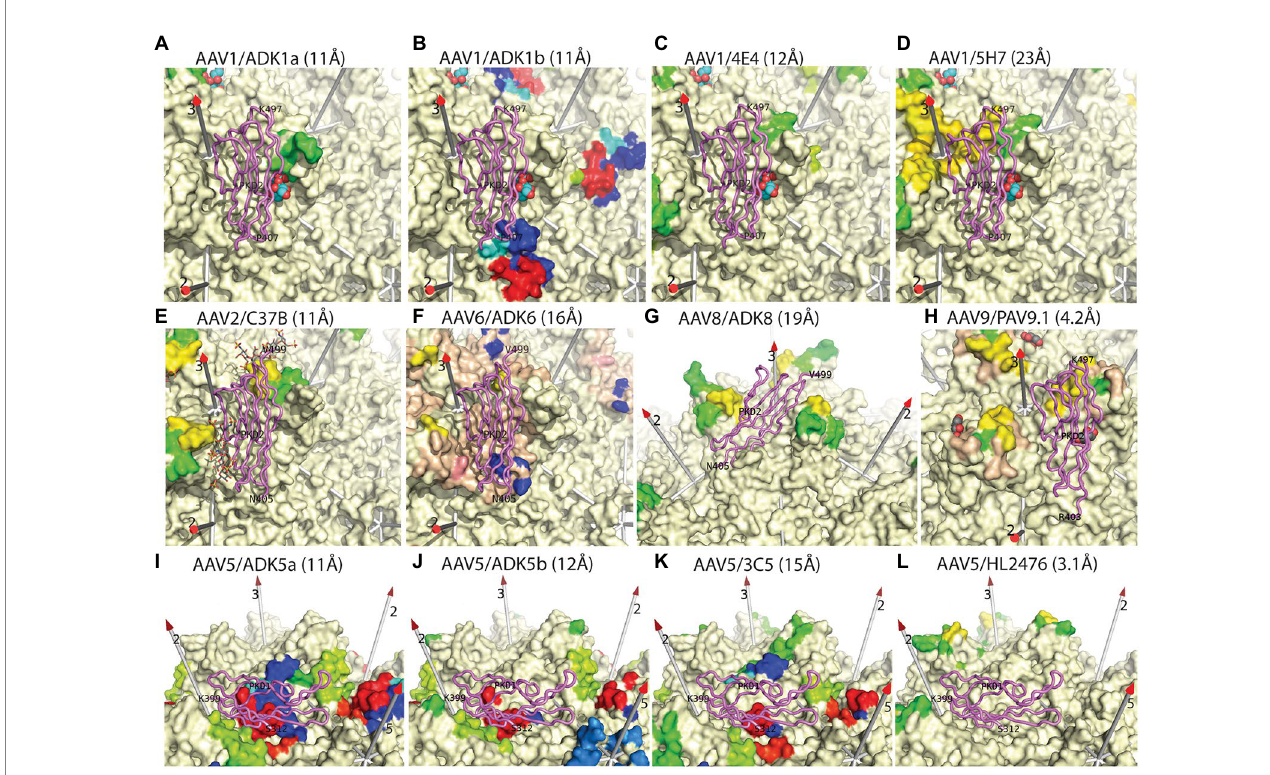
FIGURE 5 Epitopes of additional anti-AAV monoclonal antibodies. This figure is similar to that in Stagg et al. (2022), but updated to include the most recent structures of AAV-receptor complexes (violet backbone traces), with PKD1 resolved for AAV5 and PKD2 resolved for AAVR complexes with other serotypes (Meyer et al., 2019; Zhang et al., 2019; Silveria et al., 2020; Xu et al., 2022). Surface residues of several AAV serotypes are rainbow-colored according to residue number if reported to be in contact with the mAb indicated in the panel label, as inferred from cryo-EM structures at the noted resolutions (Xie et al., 2002, 2011; Nam et al., 2007; DiMattia et al., 2012; Gurda et al., 2012, 2013; Tseng et al., 2015; Bennett et al., 2018; Giles et al., 2018; Jose et al., 2019; Zhang et al., 2019; Silveria et al., 2020). Other parts of the surface are cream colored, except as noted below. Wheat-colored regions (panels F,G ) were reported as occluded by antibody-binding (Bennett et al., 2018; Giles et al., 2018). Known glycan attachment sites are indicated as overlaid spheres for sialic acid or stick-model for fondaparinux (panels A–I ) (Huang et al., 2016; Xie et al., 2017), while amino acids implicated in glycan-binding by mutational analysis are salmon-colored in panel F (Xie et al., 2011; Huang et al., 2016). Conclusions to be drawn from this comparison are: (1) many neutralizing antibodies occlude glycan attachment, but not all; (2) the binding of all nAb conflicts with the serotype-relevant AAVR domain. In most cases, PKD1 (AAV5) or PKD2 (other serotypes) lies directly over the neutralizing epitope, but for HL2476 (panel L ) conflict is with unseen inter-domain